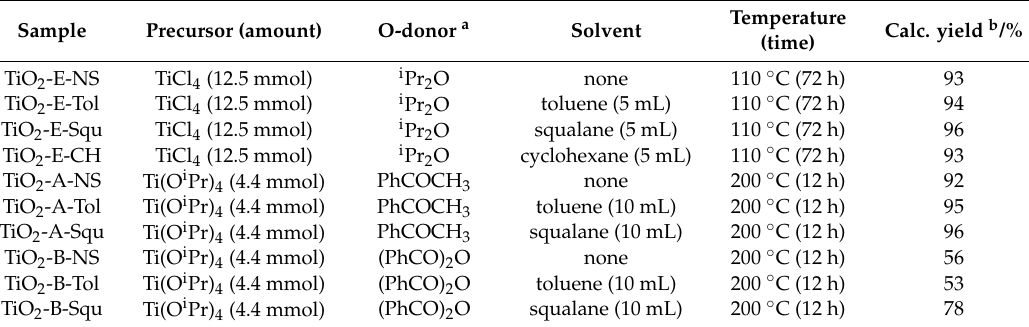
Table 1. Reaction conditions for the synthesis of the different TiO 2